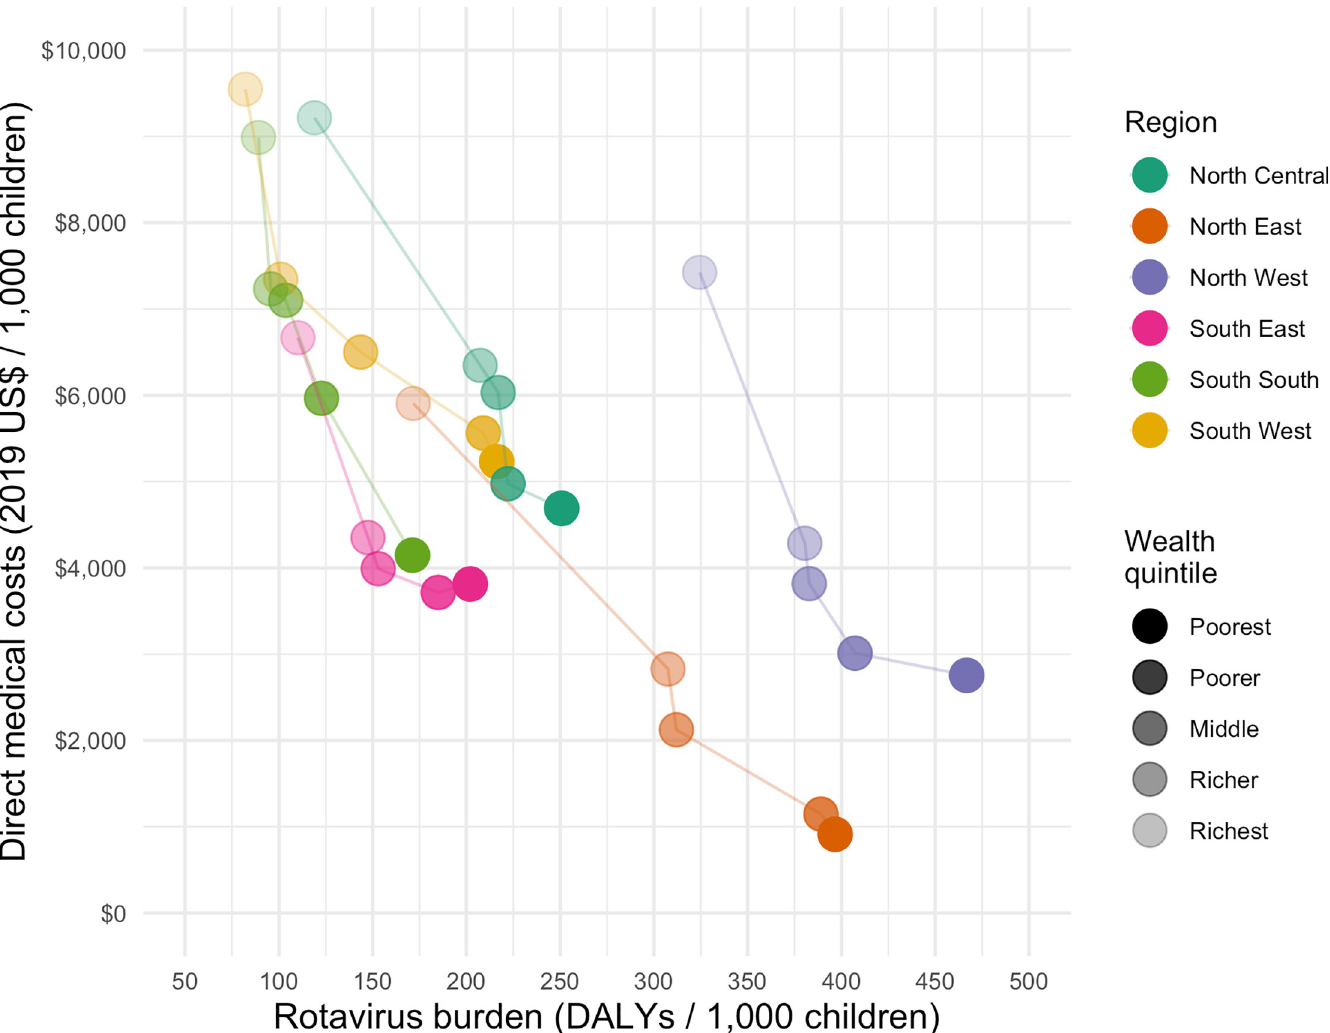
Fig 2. Estimated direct medical costs of rotavirus vaccination and rotavirus mortality burden across regional quintiles in Nigeria during the first five years of life.